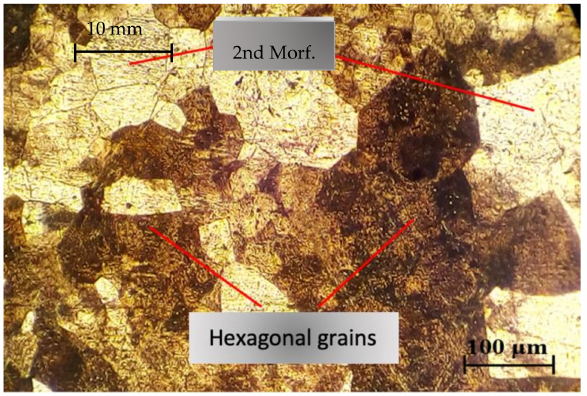
Figure 2. Standard sample of the tantalum alloy, extracted from the non-heat-affected